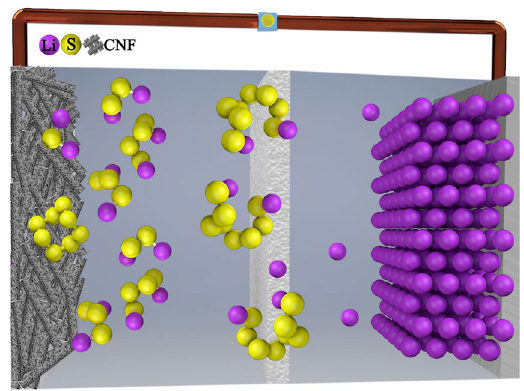
Figure 2. Schematic illustration of the Li-S cell configuration based on semi-liquid and fluorine-free catholyte, binder free and self-standing carbon nanofibers (CNF) and lithium metal